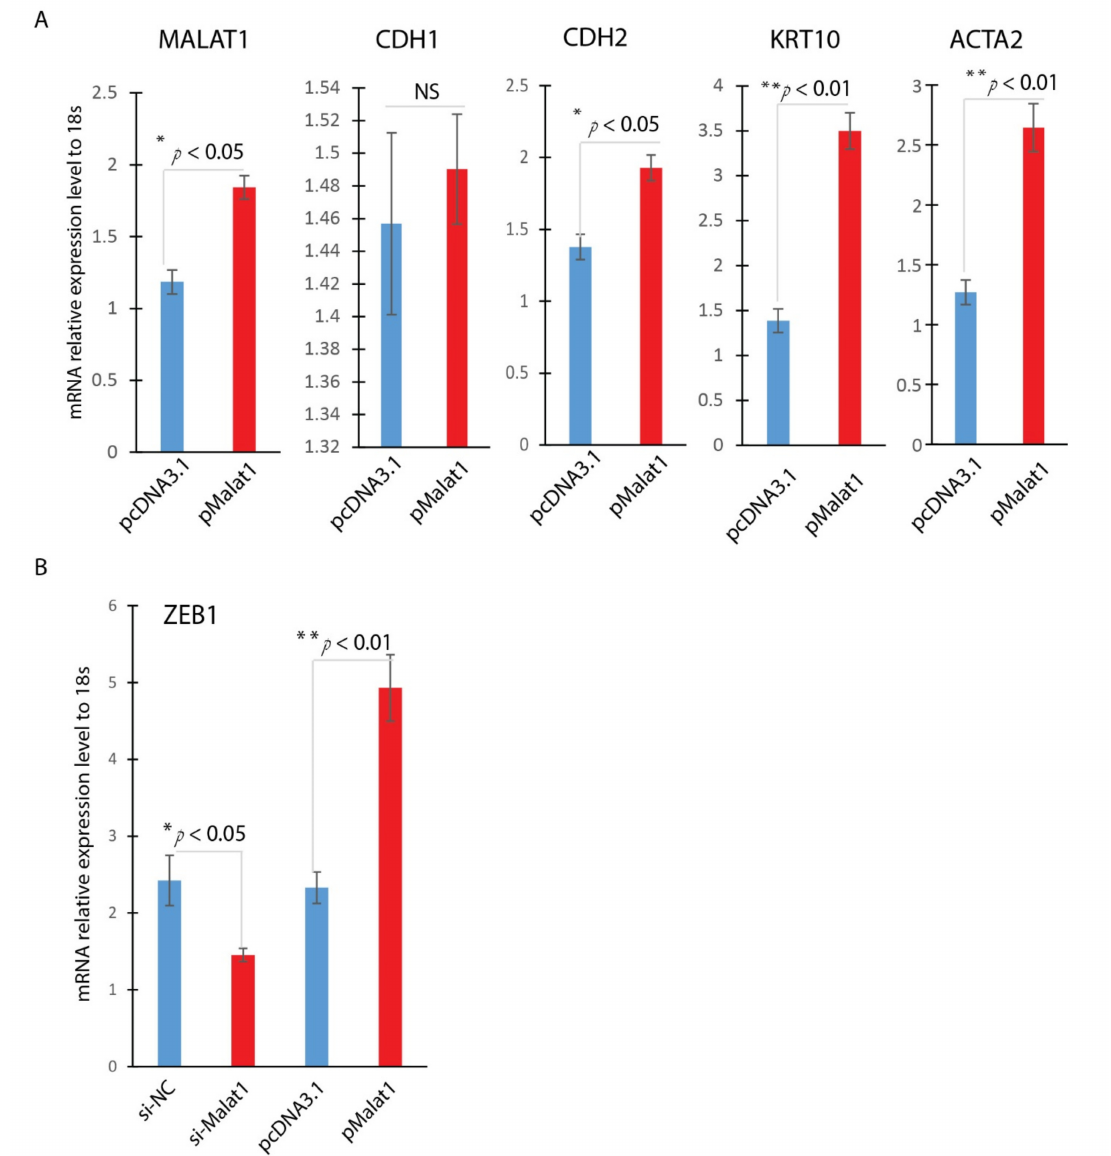
Figure 4. MALAT1 induces ZEB1. Overexpression or knockdown of MALAT1 gene expression was achieved by plasmid transfection or siRNA technology in HaCaT cells. ( A ) Overexpression of Malat1 induces EMT mesenchymal markers (CDH2, KRT10, and ACTA2); ( B ) ZEB1 was significantly induced by MALAT1 overexpression and reduced by MALAT1 knocking down by Realtime qPCR analysis (mean ± SD, n = 3 per group, * p < 0.05, ** p <